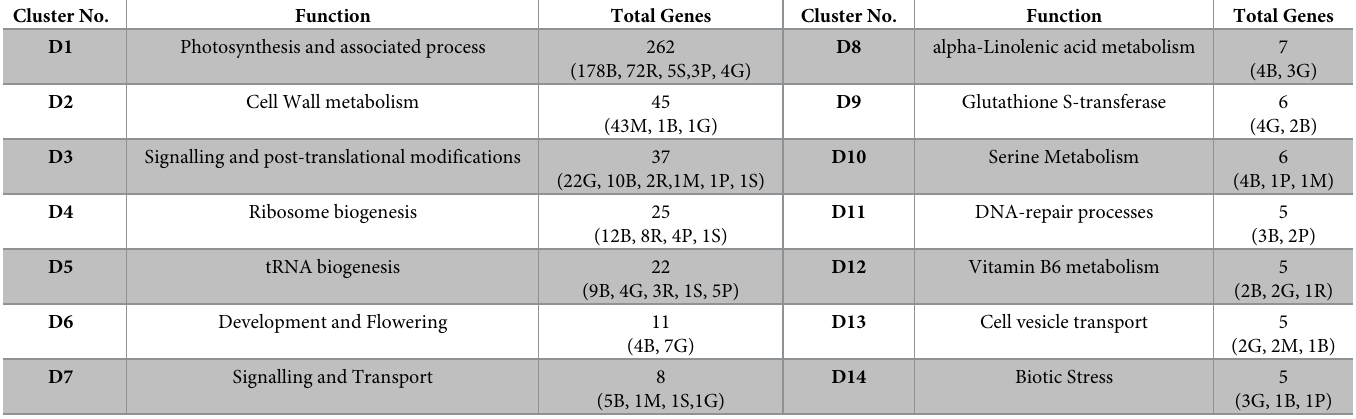
Table 5. Functional enrichment of 17 gene clusters identified in down-regulated drought tolerant network (dDTN) using MCL algorithm. (B: Blue, P: Purple, G: Green, M: Magenta, S: Salmon). Cluster